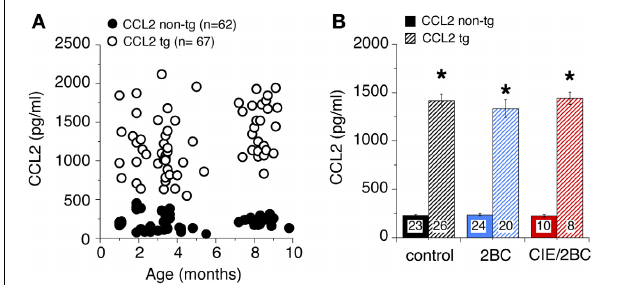
FIGURE 1 | Levels of CCL2 in CCL2-tg and non-tg hippocampus determined by ELISA. (A) CCL2 levels in ethanol naïve CCL2-tg and non-tg hippocampus at ages ranging from 1 to 10 months. (B) Mean values for CCL2 levels in CCL2-tg and non-tg hippocampus in the three treatment groups. Ethanol naïve and ethanol exposed mice were approximately 7–9 months of age when CCL2 levels were determined ( ∼ 1 month after the termination of ethanol exposure). Numbers in bars are the number animals measured. ∗ Statistically significant difference ( p < 0 . 05, unpaired t -test) from non-tg of the same treatment